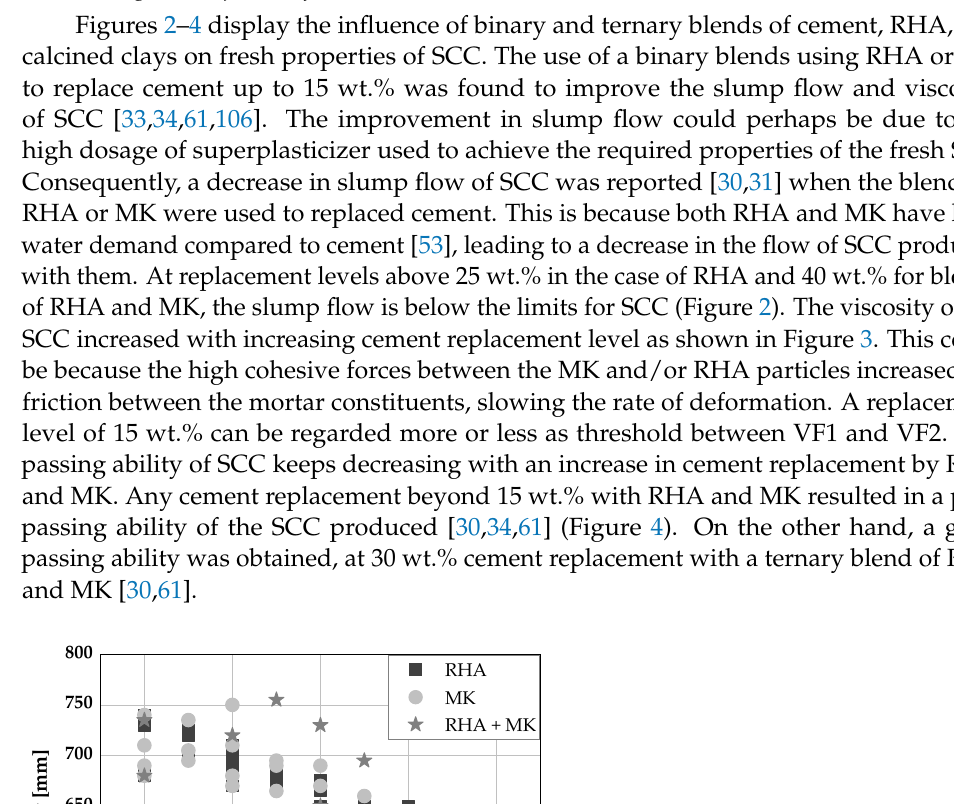
Figure 3. Viscosity of SCC: Chopra et al. [31] , Kannan [30] , Gill [61] , and Madandoust [34]. Figure 4. Blocking ratio of SCC: Chopra et al. [31] , Kannan [30] , Gill [61] , Madandoust [34] .